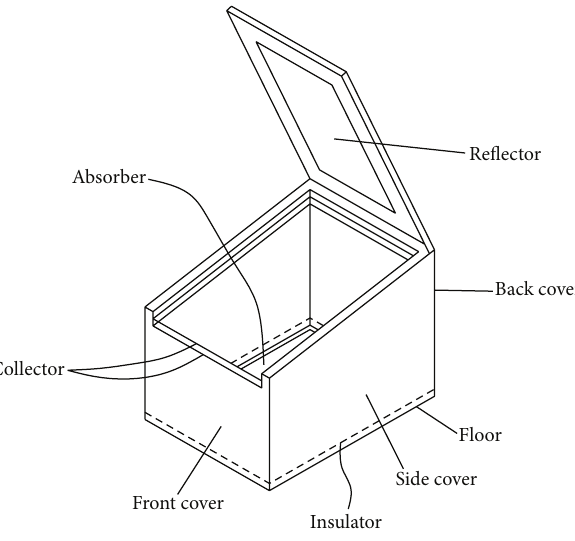
Figure 1: Box-type solar